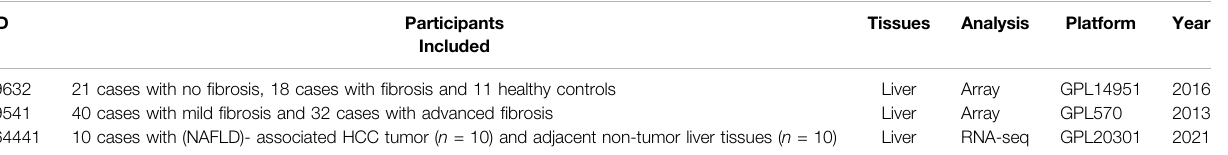
TABLE 1 | Characteristics of the included microarray datasets.